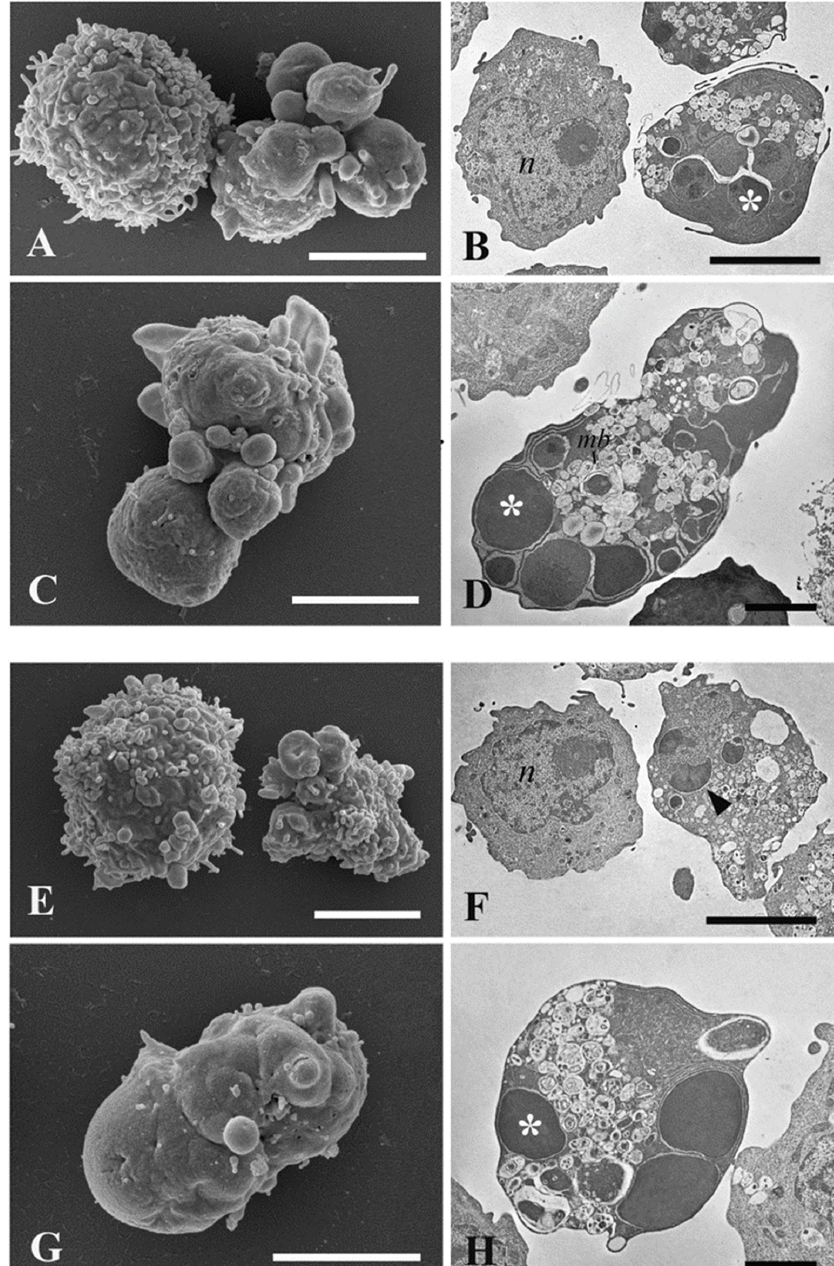
Figure 7. SEM and TEM investigations of ultrastructural changes induced by Kompolti hemp and Chinook hop EO treatments on HL60 cells. ( A – D ) Micrograph of hemp EO treated HL60 cells. ( E – H ) Micrograph of hop EO treated HL60 cells. n , nucleus; arrow, dead cell; mb , multilamellar bodies ; asterisk, fragmented nucleus . Bars = ( A – C , E – G ) 5 μm; ( D , H ) 2 μm.